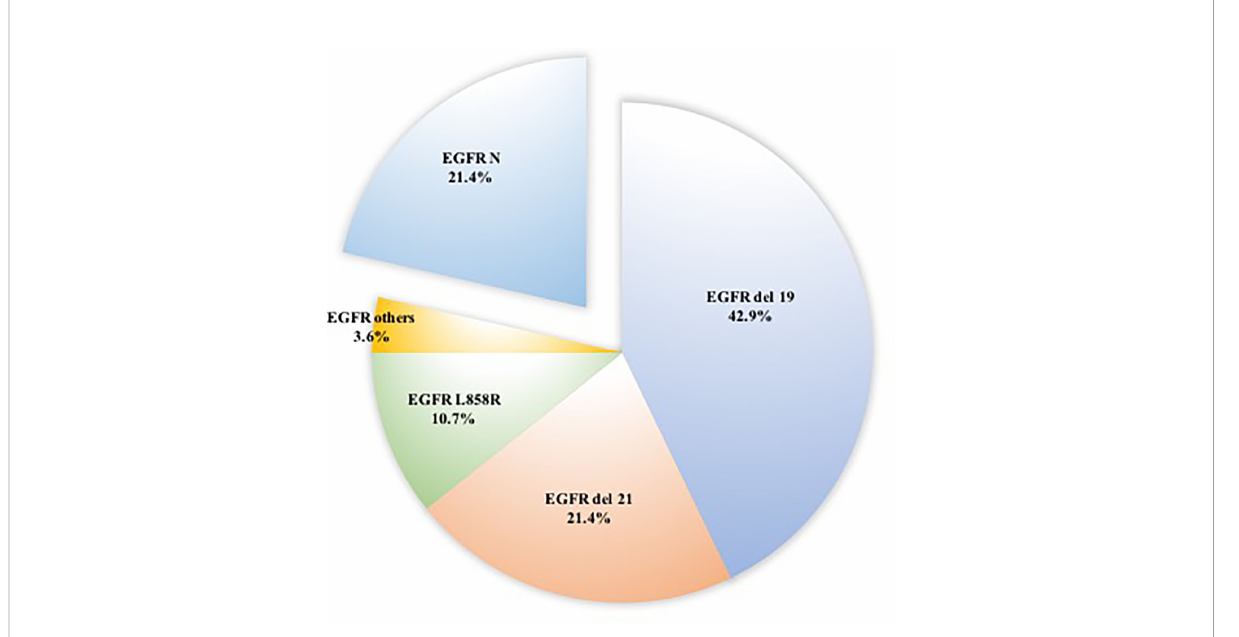
FIGURE 1 Distributions of 22 patients with EGFR mutation in surgically resected ground-glass nodules.